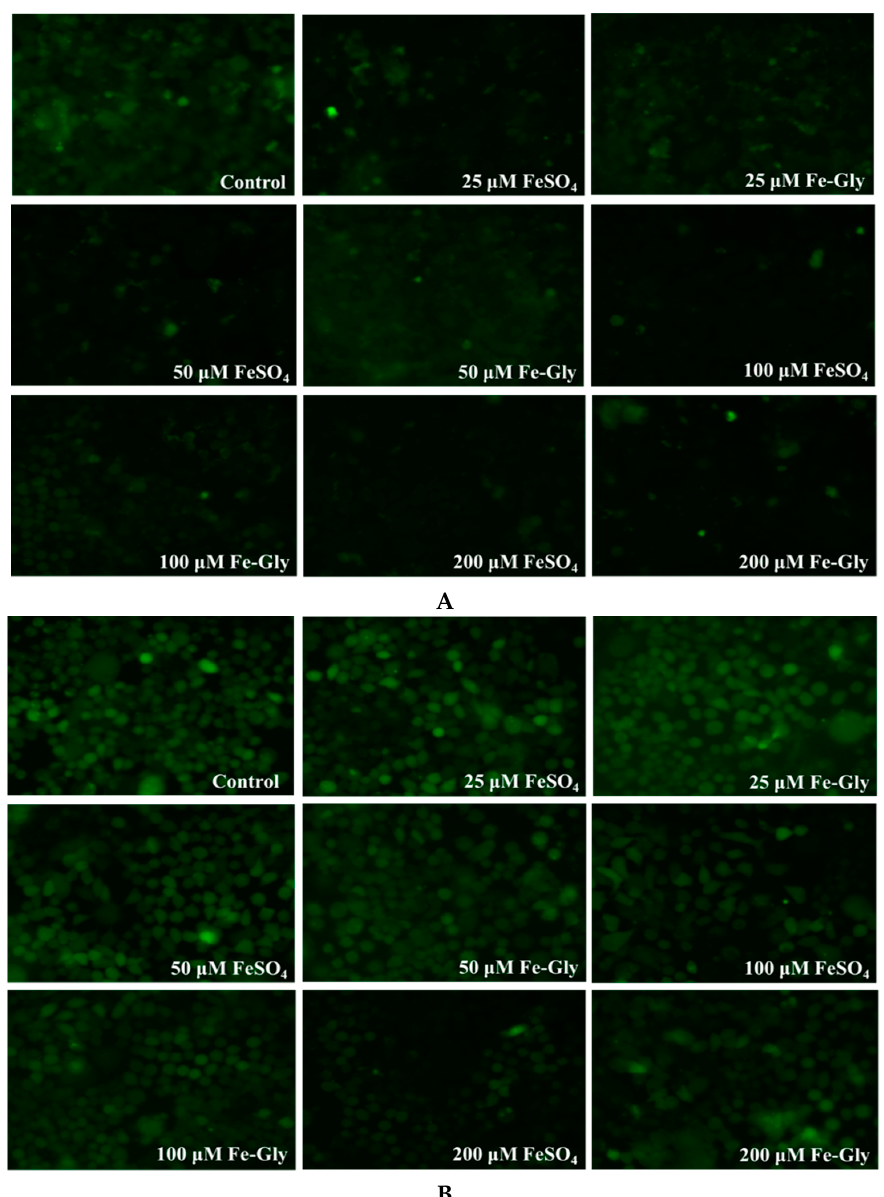
Figure 4. Live cell fluorescence imaging (200x) of labile iron in wild-type cells and DMT1-knockout cells after treated with different concentrations of FeSO 4 and Fe-Gly for two hours. ( A ) Fluorescence imaging of labile iron in wild-type cells; ( B ) Fluorescence imaging of labile iron in DMT1-knockout